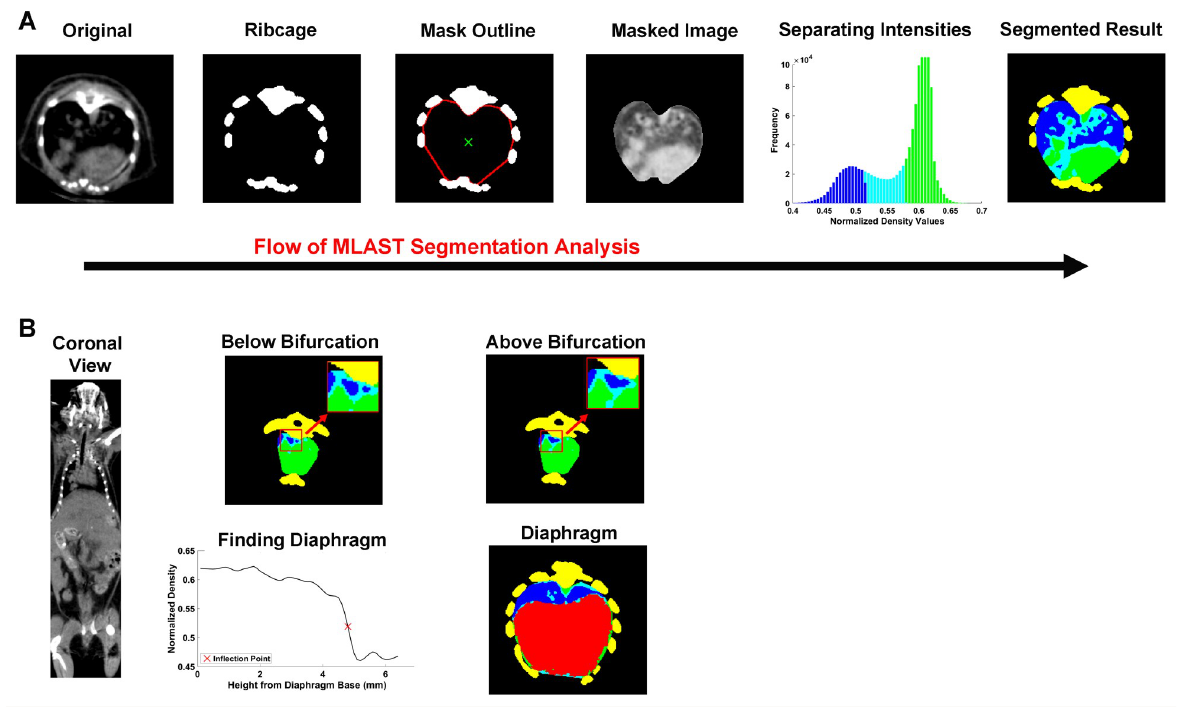
Fig 2. Schematic of MLAST analysis. (A) Depiction of MLAST’s segmentation algorithm. The original microCT 2D image contains the densities of various tissues observed in a thoracic scan. The ribcage provides a high contrast for thresholding. The interior points of the rib regions are used to create a mask of the thoracic cavity. The densities of the voxels within the masked image are segmented with a k-means clustering algorithm and the intensities are classified into 3 tissue types: soft tissue (green), lung (blue), and intermediate (cyan). The final segmented result is shown in 2D and applied to all slices in the z-stack. (B) Depiction of how MLAST detects the cranial and caudal boundaries of the thoracic cavity. The cranial boundary is determined by the bifurcation of the trachea. Below the bifurcation, the two tracheal regions (colored blue and shown in inset) are separate. Tissues above the bifurcation, where the two regions are no longer separable, are excluded from the final segmentation. On the caudal end, the diaphragm is segmented based on density changes in the z-trace of each voxel. The resulting diaphragm (red) is removed from the thoracic counts of soft tissue, lung, and